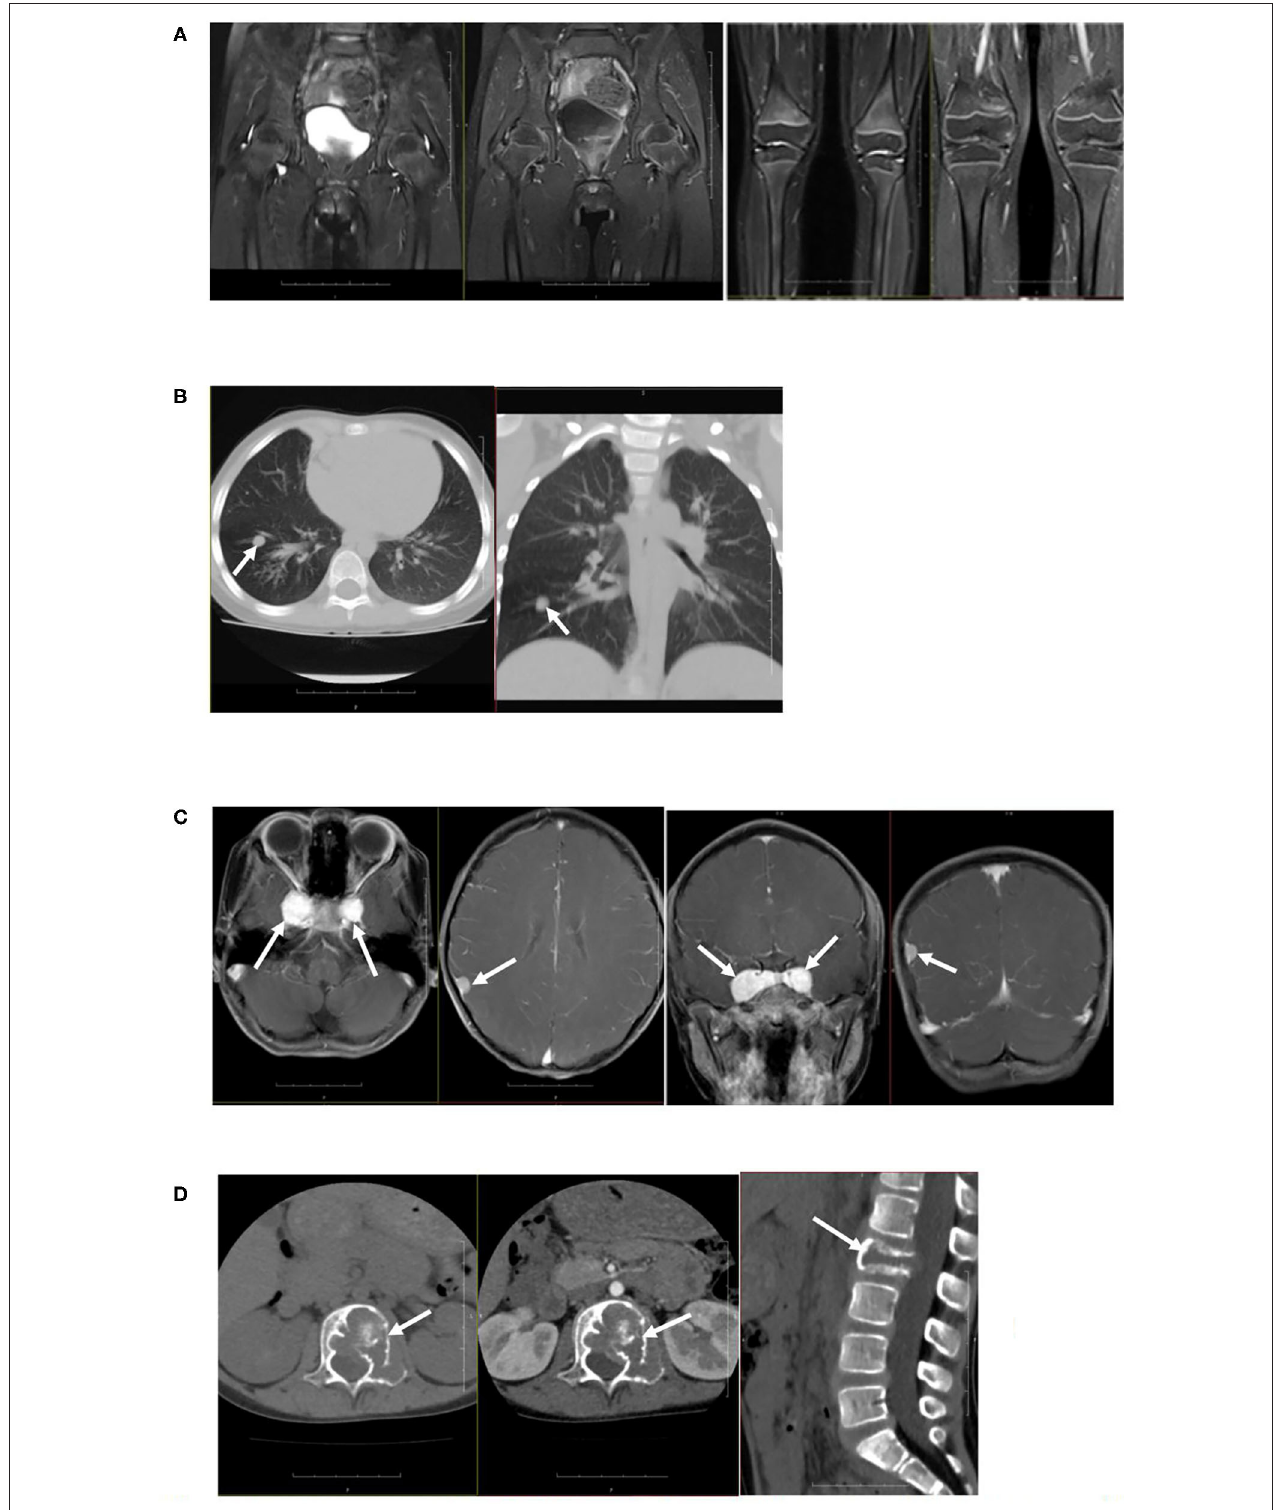
FIGURE 2 | Imaging examination. (A) Plain and enhanced MRI scanning of the knee joints and hip joints showed that the synovium of bilateral knee and hip joints were slightly thickened and enhanced, with a small amount of effusion in joints. (B) Plain CT scanning of lungs showed multiple nodules and stripe-shaped shadows in bilateral lungs, and the size of the largest shadow was 0.63 × 0.74cm. (C) Plain and enhanced MRI scanning of the skull showed nodular lesions at the parasellar and meninges of the right parietal lobe. (D) Plain and enhanced MRI scanning of the spine showed bone mass destruction of the L2 vertebral body and left vertebral